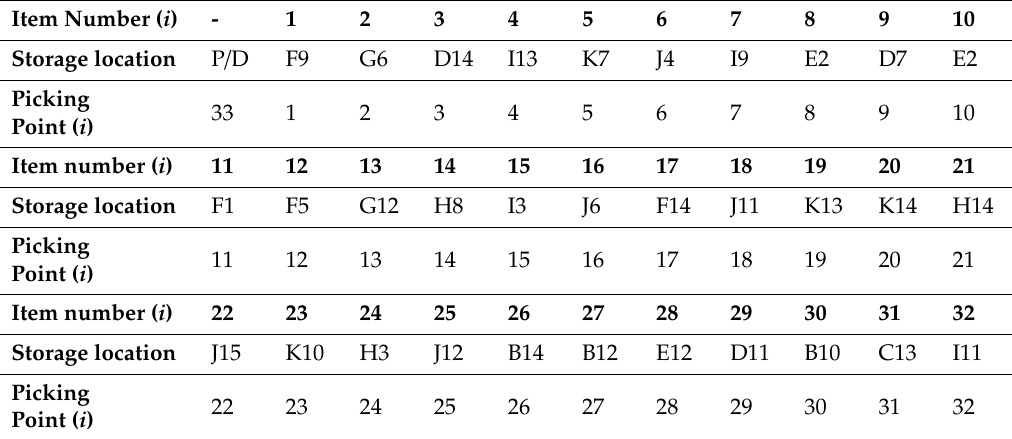
Table 6. The item numbers and picking point